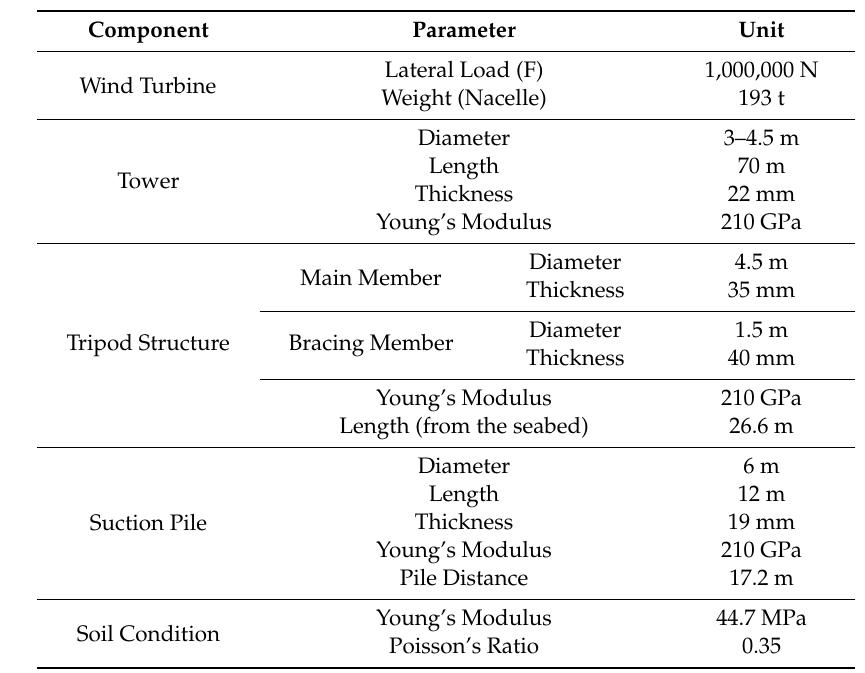
Table 4. Design parameters of the wind turbine system.